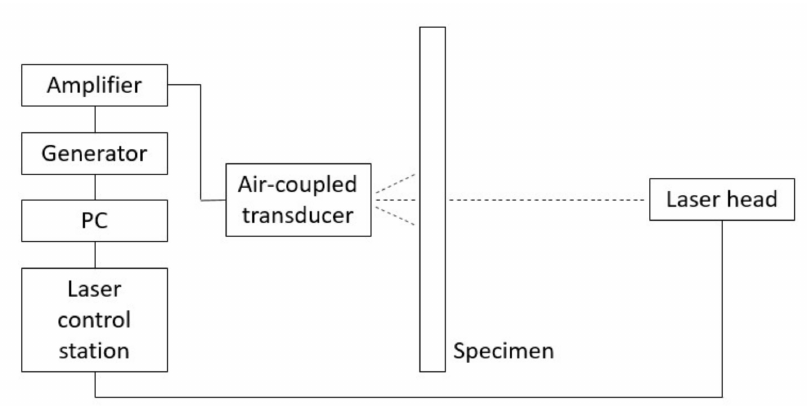
Figure 3. Scheme of full non-contact waves generation and sensing setup.